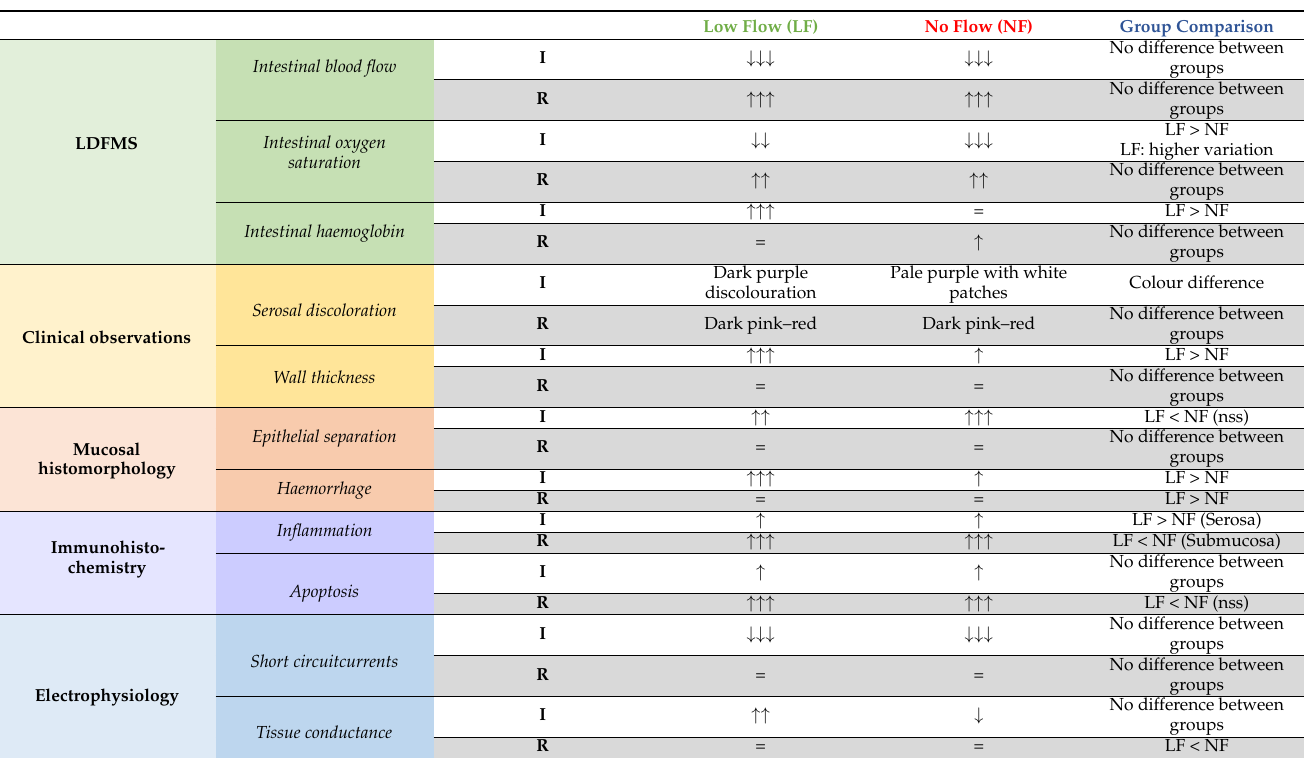
Table 5. Summary of the results comparing the progression of LF and NF ischaemia. LDFMS Laser Doppler fluxmetry and microlightguide spectrophotometry; I Ischaemia; R Reperfusion; = no (further) changes; ↓ mild/ ↓↓ moderate/ ↓↓↓ severe decrease; ↑ mild/ ↑↑ moderate/ ↑↑↑ severe increase;